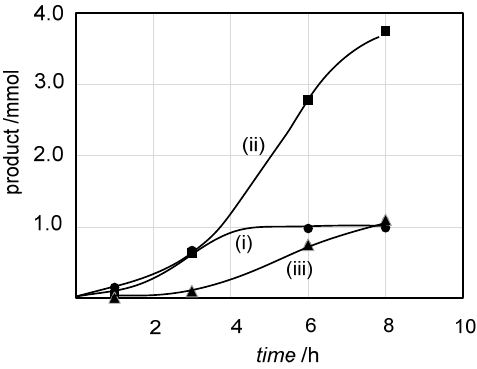
Figure 4. Reaction profile of ethylene oligomerization catalyzed by NiBr 2 ( L1 )–MAO; (i) 1-butene, (ii) 2-butene, (iii) 1-hexene. Ethylene: 1 atm, Ni: 0.010 mol, [Al]/[Ni] = 300, toluene 10 mL, 25 °C. Product amounts are determined by GPC analysis.